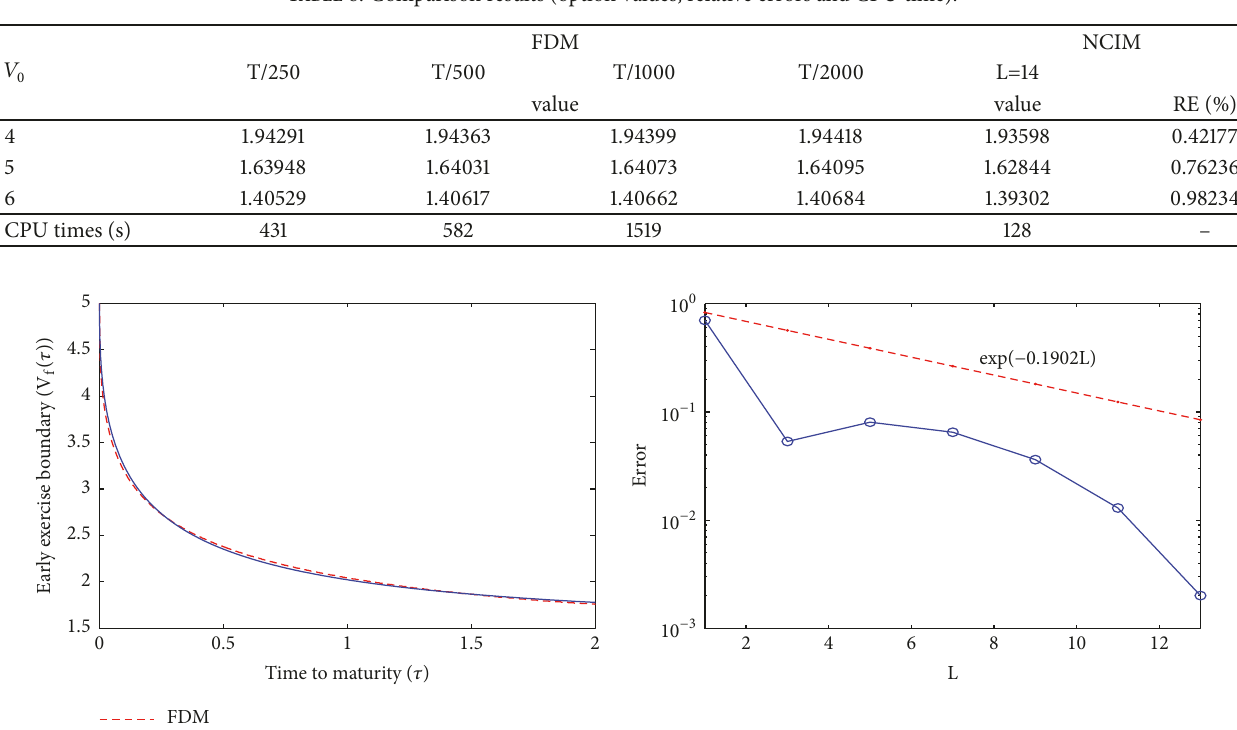
Table 8: Comparison results (option values, relative errors and CPU time).